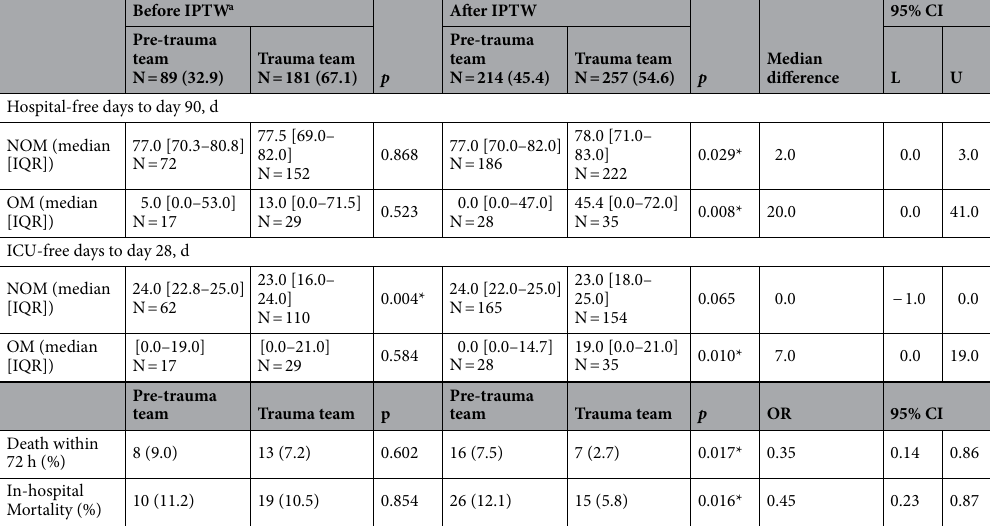
Table 3. Secondary outcomes. NOM non-operative management; OM operative management; PLT Platelet; TAE transarterial embolization. a IPTW model includes sex, age, comorbidity, trauma mechanism, shock index, Glasgow coma scale, injury score of head and chest, liver AAST injury grade, treatment for liver laceration, tranexamic acid use, transfusion quality, and RBC resuscitation volume. * p <